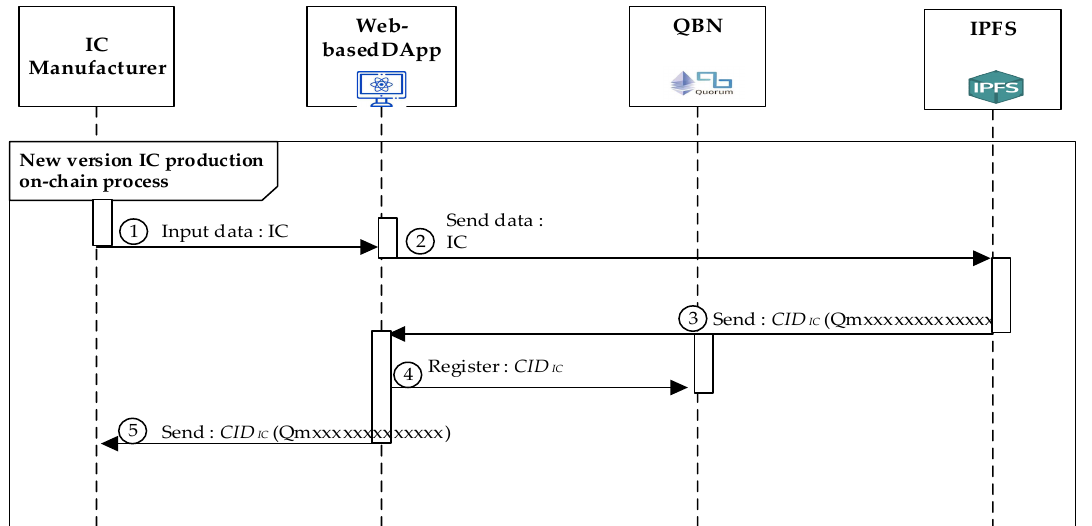
Figure 6. The sequence diagram in producing the new version of module.